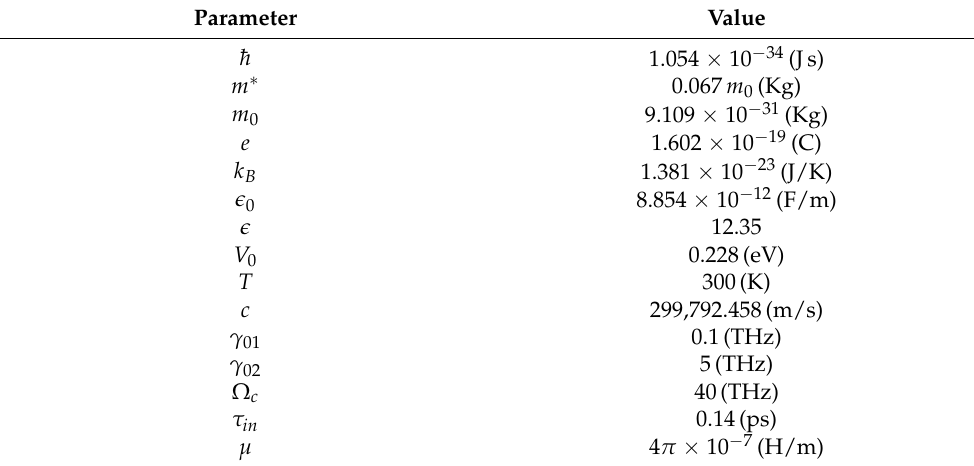
Table 1. List of parameters used in the